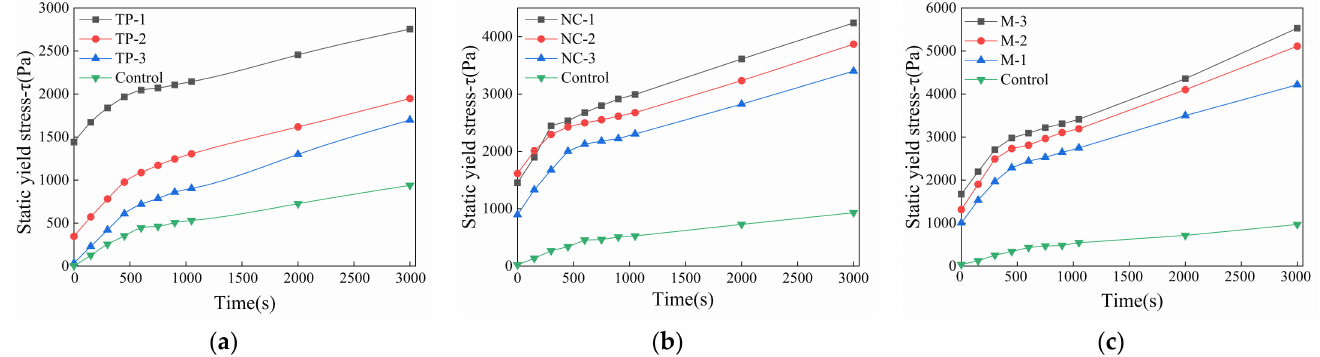
Figure 12. The static yield stress development with time in printed materials with ( a ) single-doped TP, ( b ) doped NC and 3‰ PCE and ( c ) double-doped TP and